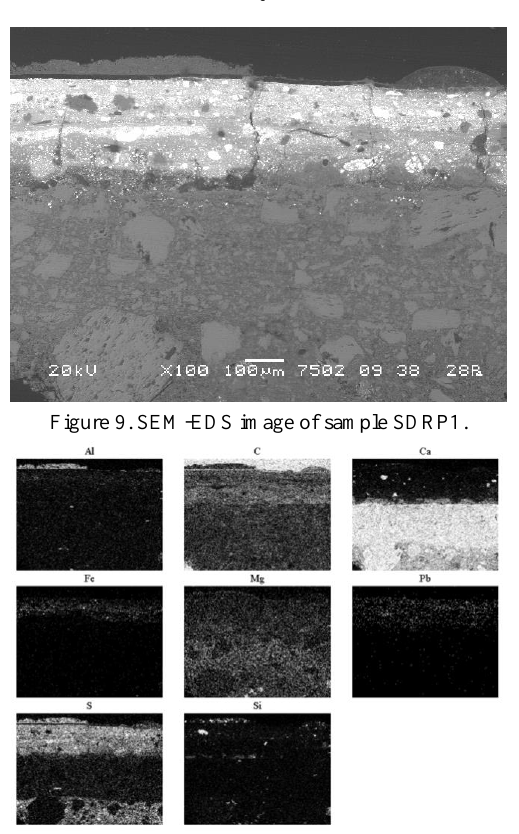
Figure 10. Map of the elements of sample